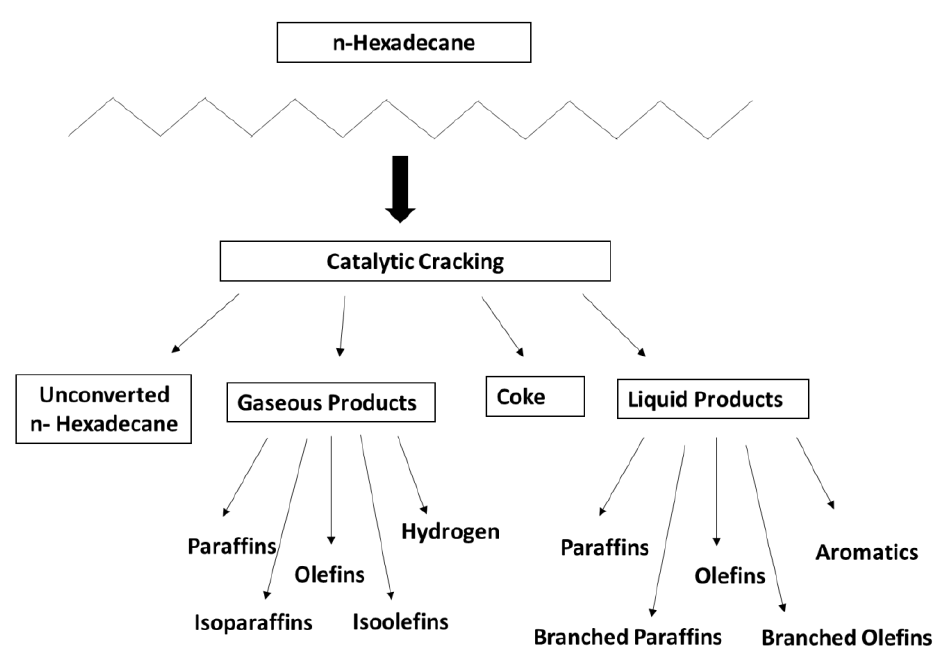
Figure 12. Proposed reaction mechanism of n-hexadecane cracking.